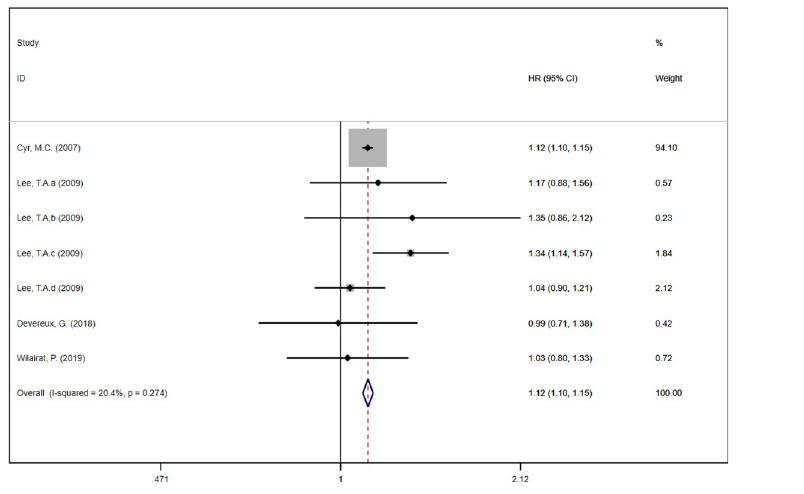
Fig 4. Forest plot of hospitalization